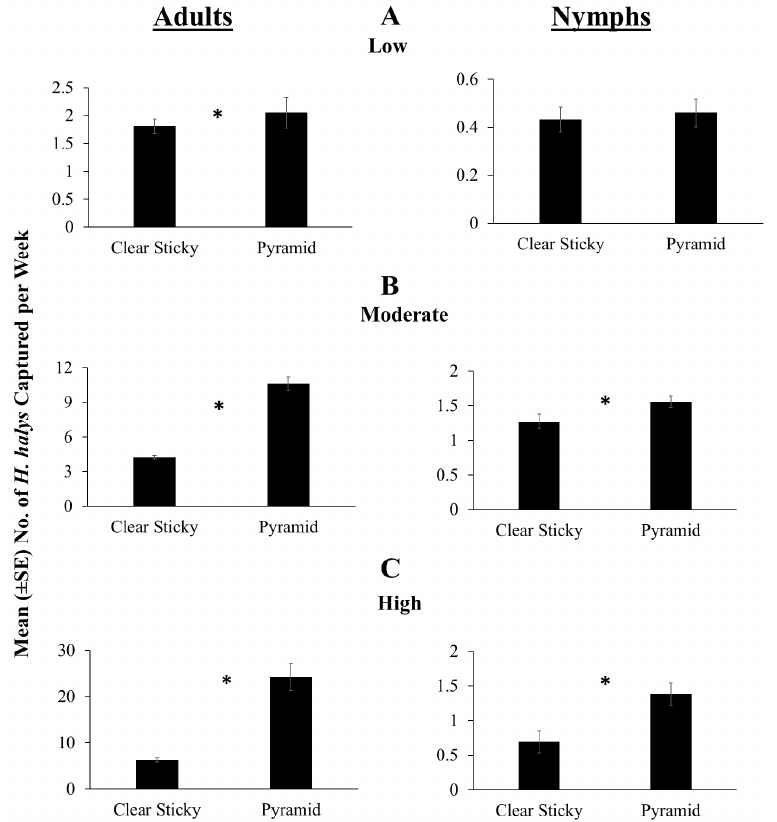
Figure 2. Results comparing the effectiveness of clear sticky traps and pyramid traps under ( A ) low, ( B ) moderate and ( C ) high H. halys relative population densities. Data pooled across all lure treatments. Due to the differences in the sampling period at the different locations, data obtained from 31 May to 3 October were used for the low relative population density sites while for moderate and high relative population density sites data were analyzed from 23 May to 3 October 2016. Asterisk indicates significant difference between the two trap designs at α = 0.05.